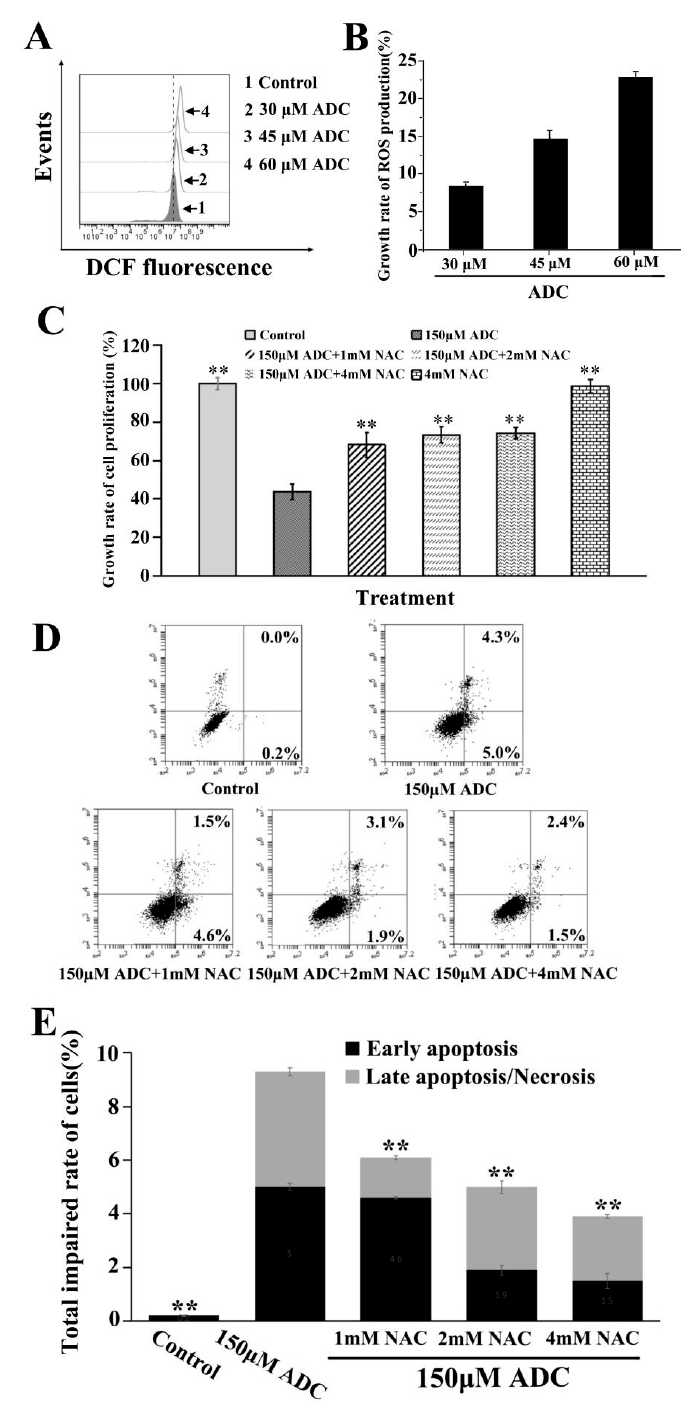
combination treatment with ADC and NAC when compared with just the ADC treatment.